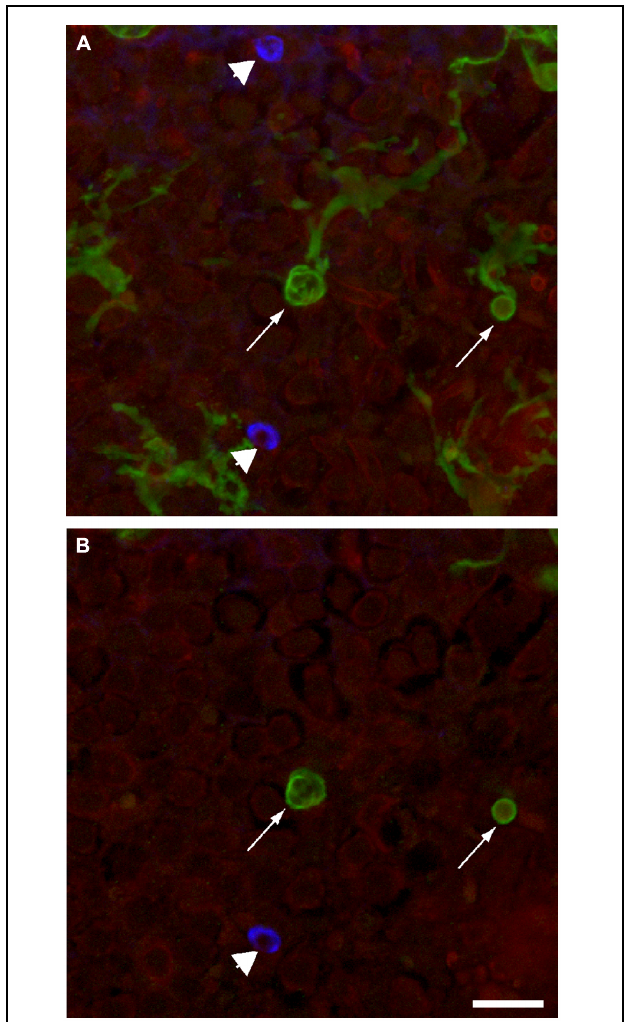
FIGURE 7 | Macrophages and actin basket phagosomes are simultaneously present in the injured mouse utricle. Calix-shaped phagocytic processes of GFP-expressing macrophages were observed in all lesioned sensory epithelia (arrows). Phalloidin staining (blue) also revealed F-actin phagosomes in these same epithelia (arrow heads). These basket-shaped structures could be distinguished from macrophages by their strong phalloidin labeling (blue). (A) Maximum intensity projection of full confocal stack. (B) Single z-section through this stack, showing a cross section through macrophage processes (green) and an F-actin phagosome (blue). Scale bar = 20 µ